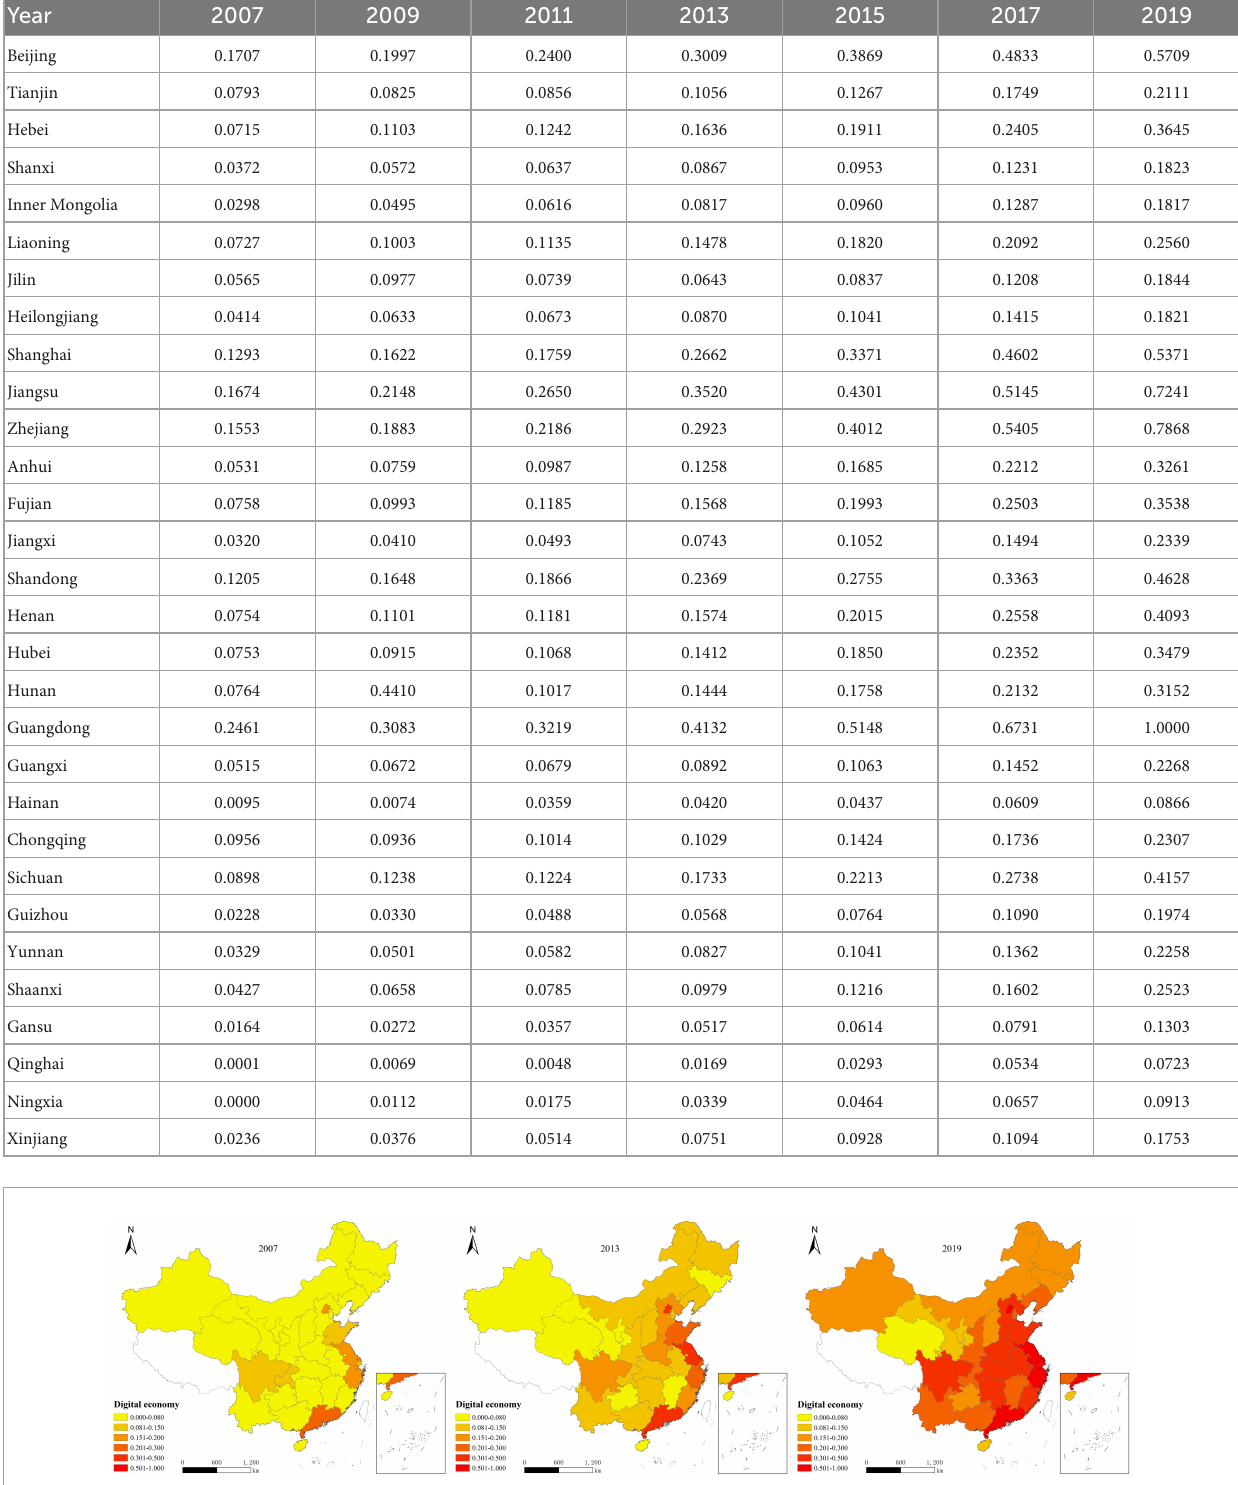
FIGURE1 Spatial distribution of China’s digital economy development level in 2007, 2013, and